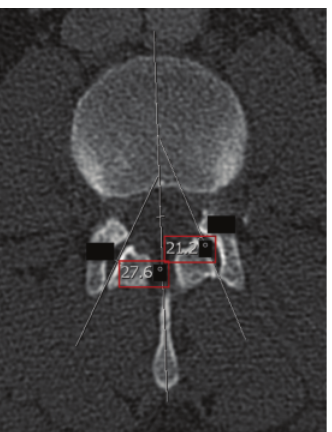
Figure 2: Measuring technique for FJ orientation. FJ orientation in the axial plane was evaluated by measuring the angle between the midline of the sagittal plane and the midline of the FJ. Coronal FJ orientation is shown on the left side, whereas sagittal orientation including measurement of FJ orientation is shown on the right side. The red box indicates the value for FJ orientation. The blacked out numbers were disregarded because they were created automatically by our software and contained irrelevant information.